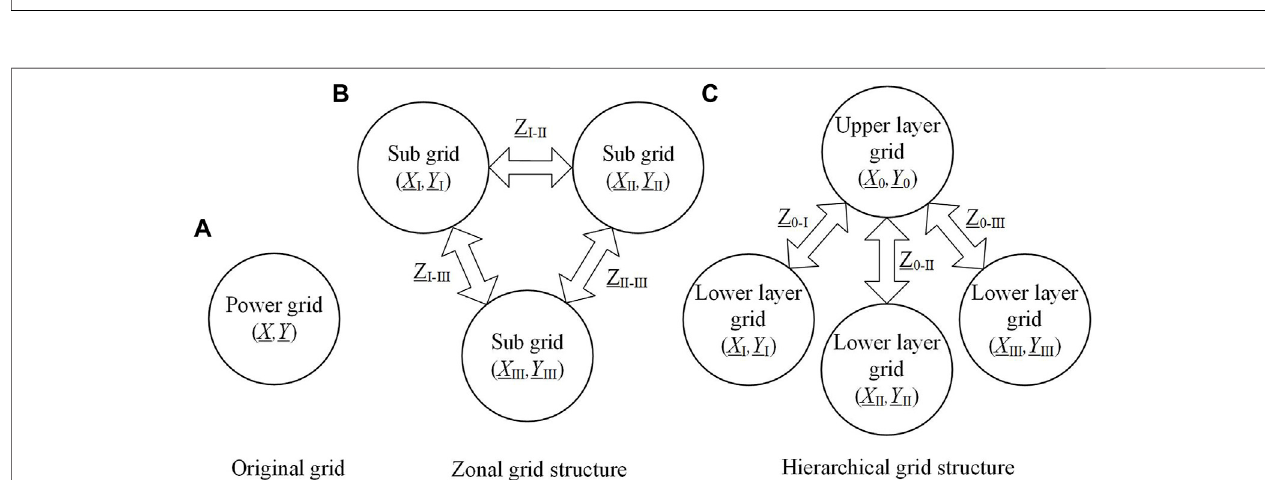
FIGURE 2 | Schematic diagrams of the typical power network structure. (A) Original grid. (B) Zonal grid structure. (C) Hierarchical grid structure.